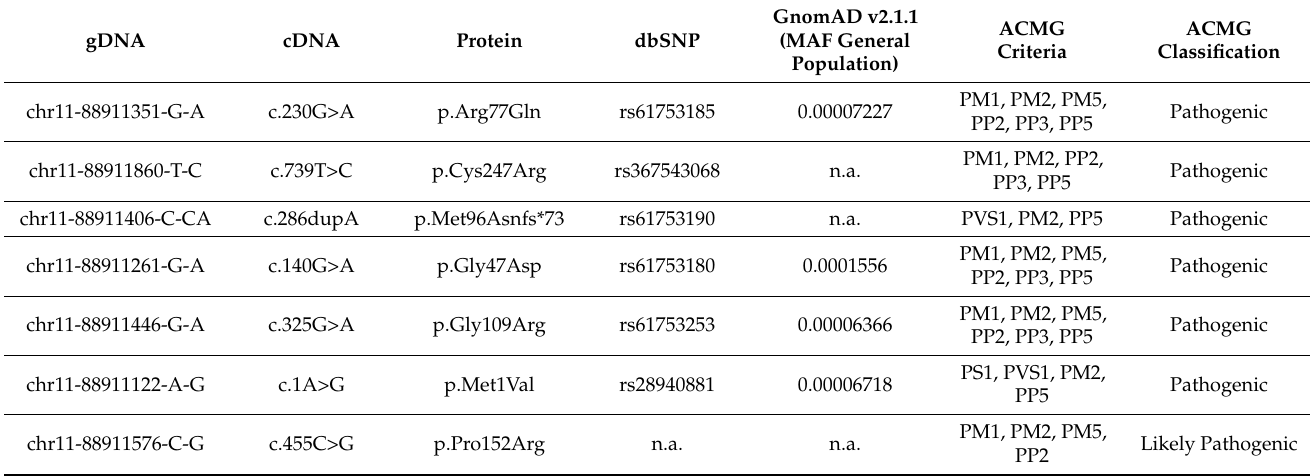
Table A1. Detailed variant